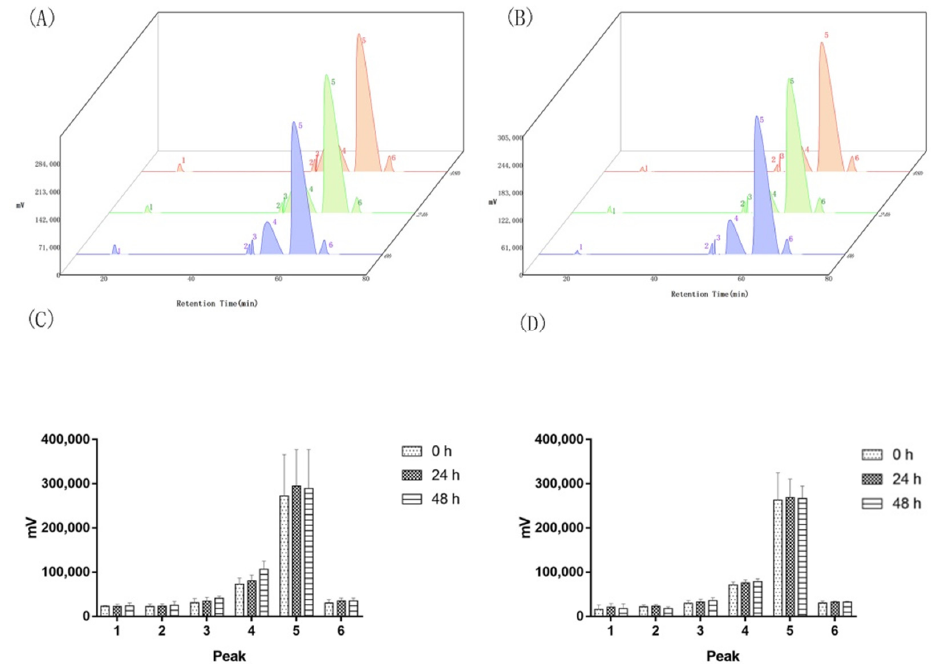
Figure A3. Cinnamomum cassia Presl powder fermentation ( A , C ): Bs-2 was added in Cassia powder and sterilized saline, and then the suspension was thoroughly mixed and incubated. Samples were taken at 0 h, 24 h, and 48 h and filtered for HPLC analysis. ( B , D ): Bs-4 was added in Cassia powder and sterilized saline, and then the suspension was thoroughly mixed and incubated. Samples were taken at 0 h, 24 h, and 48 h and filtered for HPLC analysis.